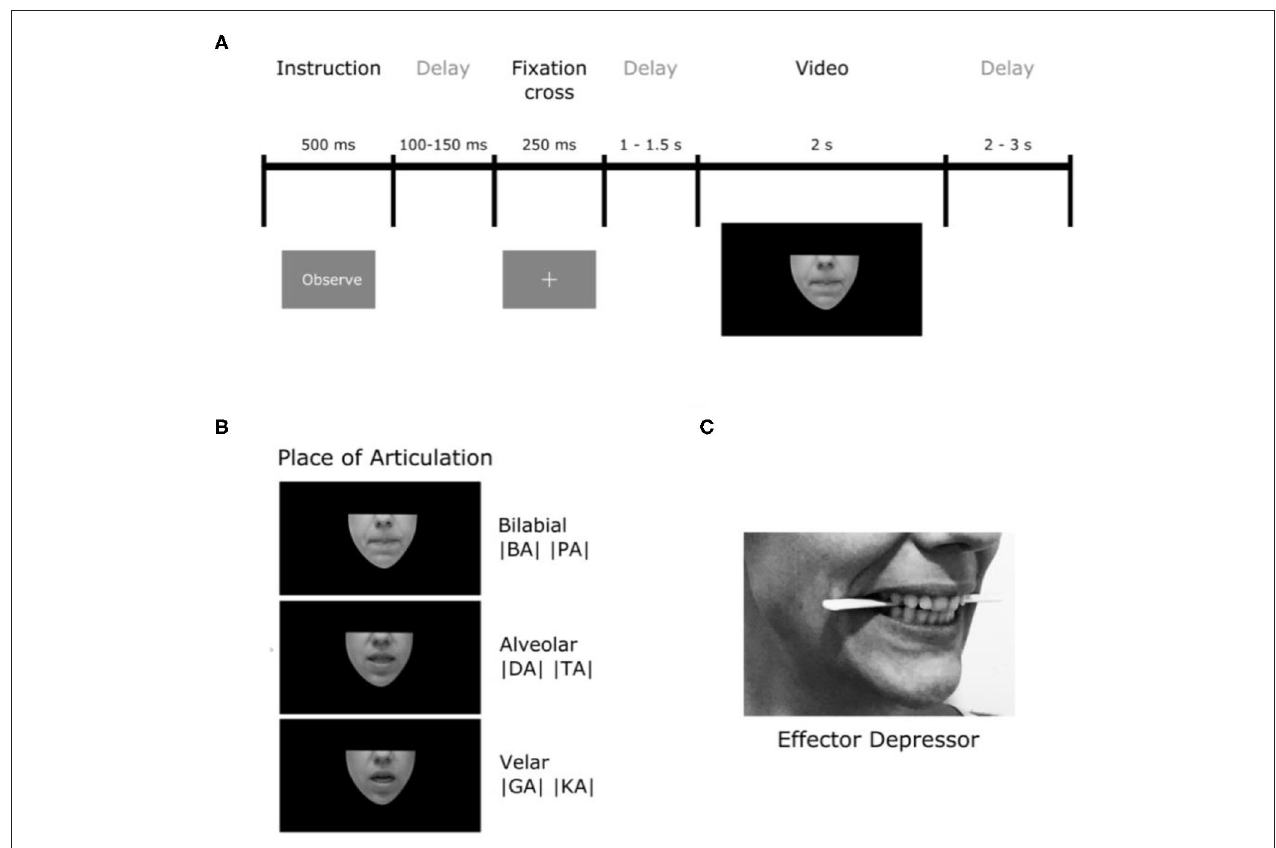
FIGURE 1 | Experimental procedure. (A) Timeline description of trials. (B) Illustration of the places of articulation (PoA) of the syllables used. (C) Depiction of the position of the effector depressor in participants’ mouths.